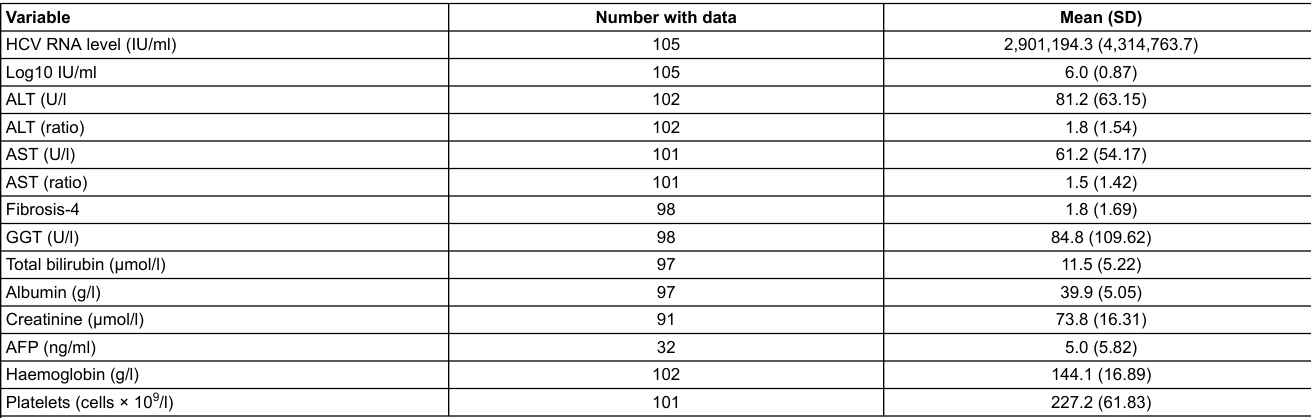
Table S3: Baseline laboratory data (safety population, N =